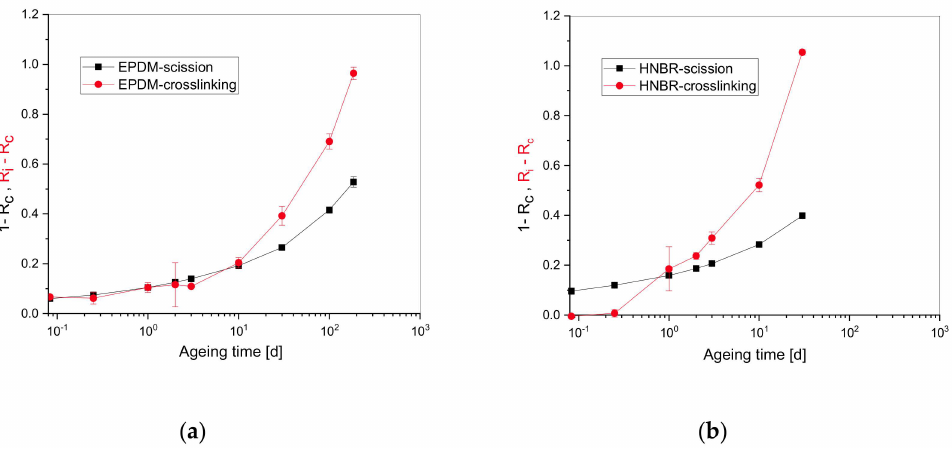
Figure 4. Evolution of cross-linking and chain scission versus ageing time for ( a ) EPDM and ( b )